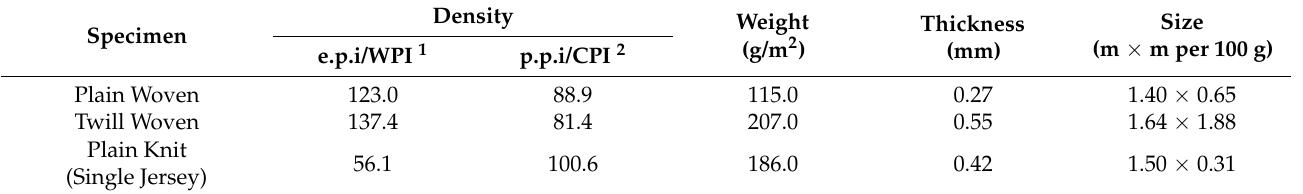
Table 1. Characteristics of the specimens.